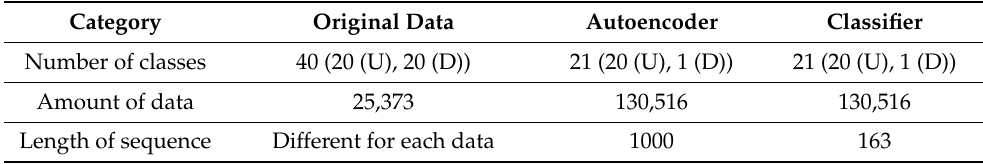
Table 1. Details of dataset (U, D : the number of users and deep